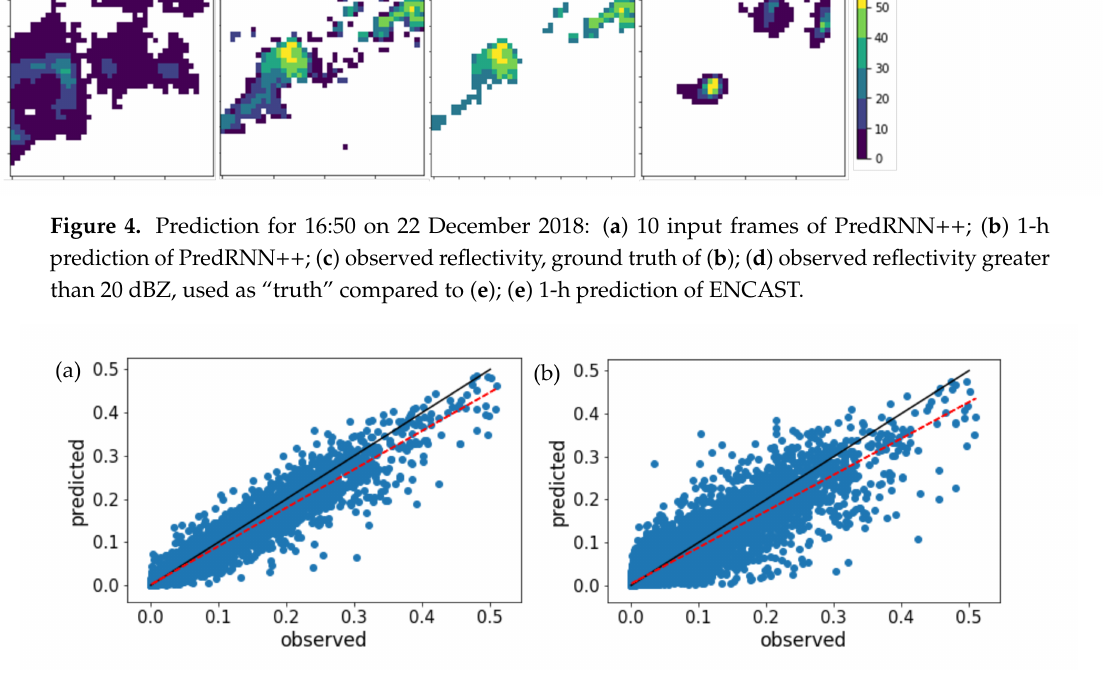
Figure 5. Scatter plot of results of PredRNN ++ for the test set (the year of 2018): ( a ) observed vs. predicted 30-min forecast; ( b ) observed vs. predicted 60-min forecast.